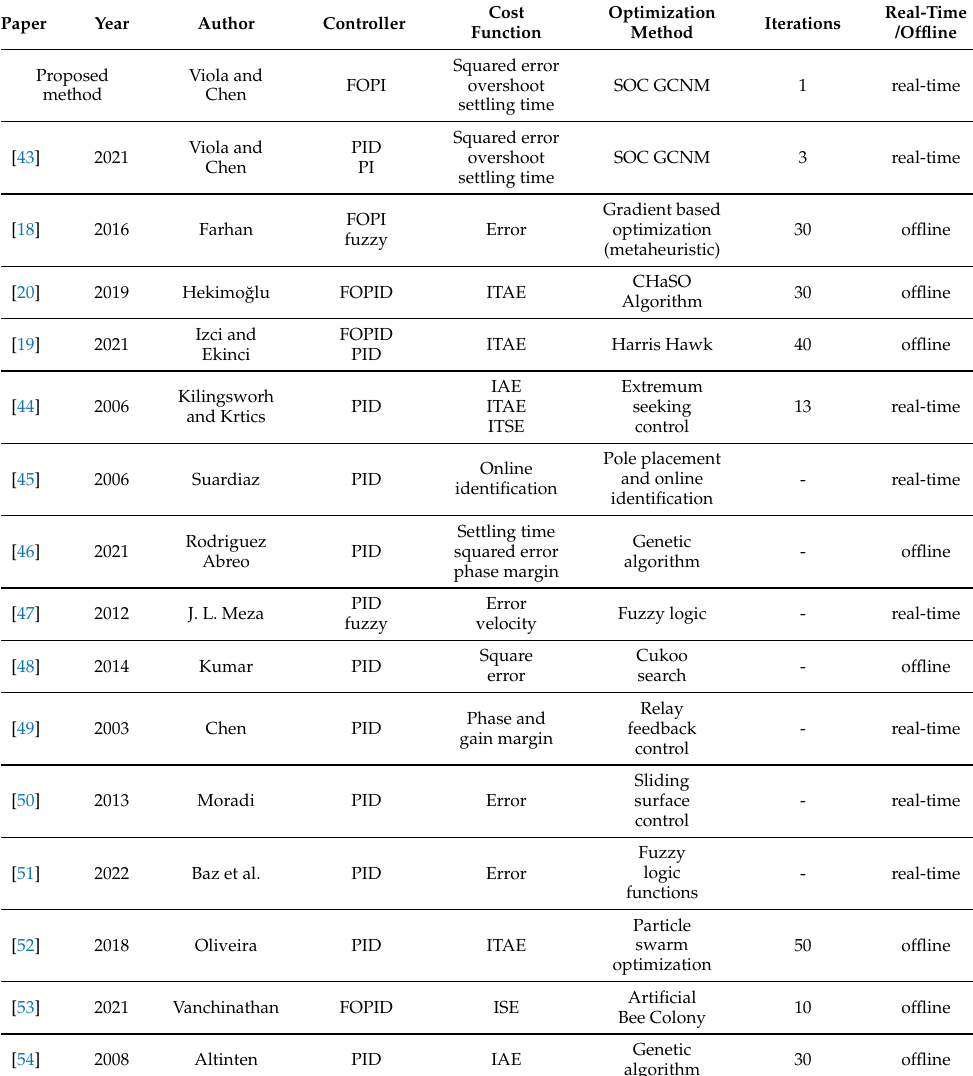
Table 3. Comparison of self tuning methods for PI, PID, FOPI, and FOPID controllers.